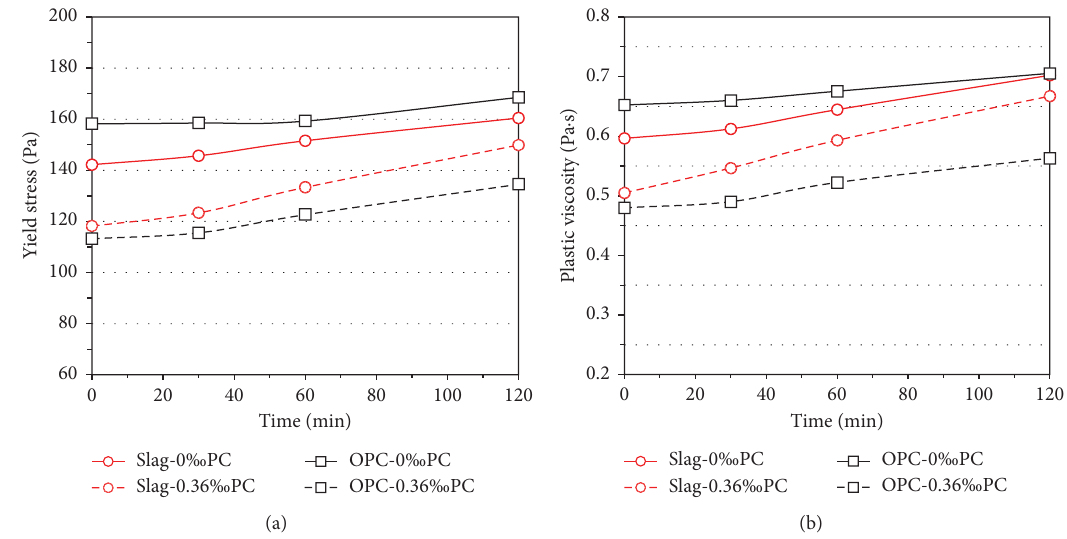
Figure 8: Time-dependent evolution of (a) yield stress and (b) plastic viscosity of CPB containing different binder types and PC dosages.